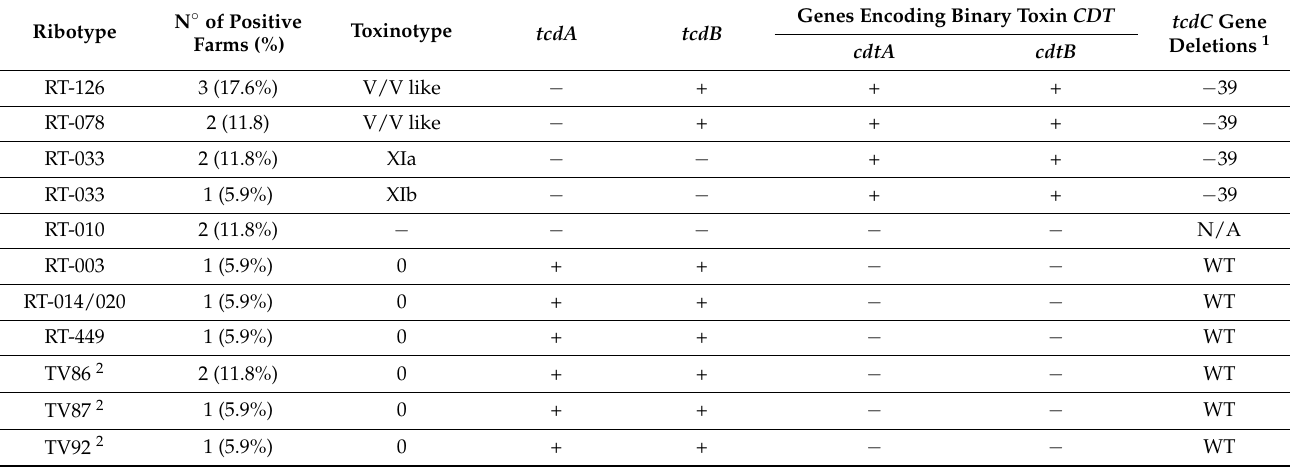
Table 3. Molecular characterisation of C. difficile isolates from calves (23 isolates from 17 farms).